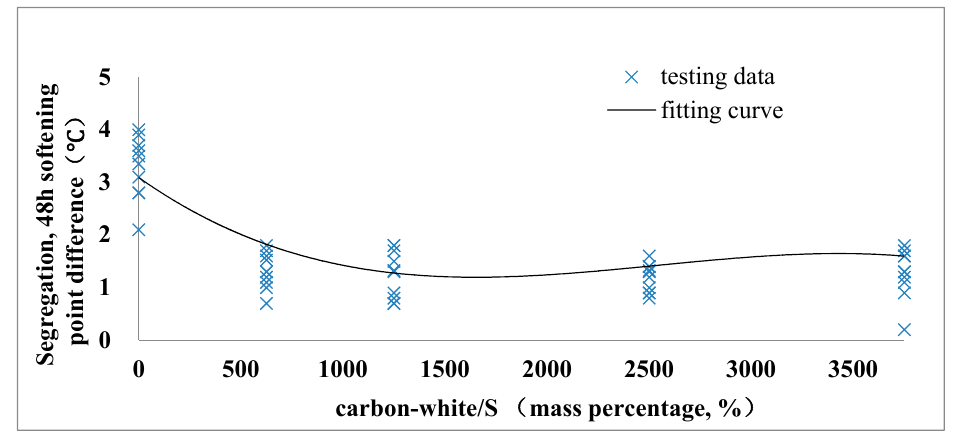
Figure 10. The relationship between carbon-white content and 48-h segregation softening point difference of SBS-modified bitumen.